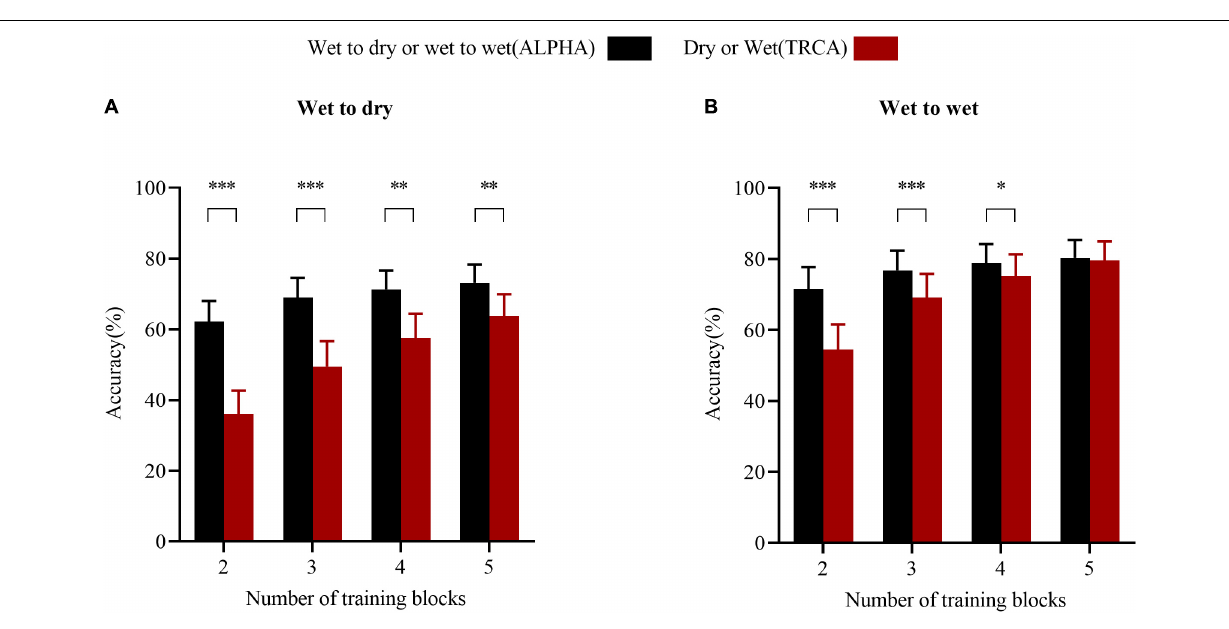
Frontiers in Neuroscience |